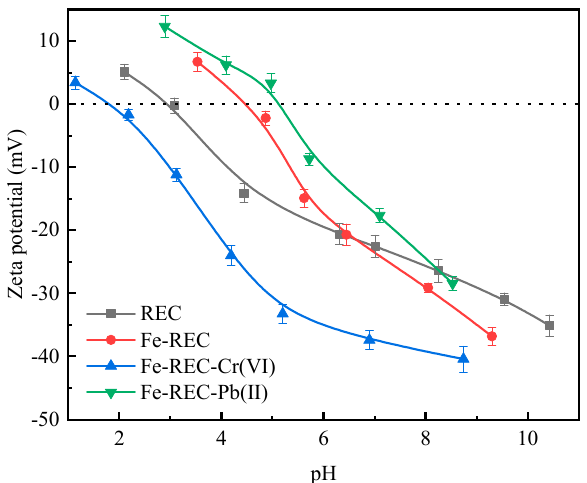
Figure 5. Zeta potential of rectorite before and after modification and adsorption.